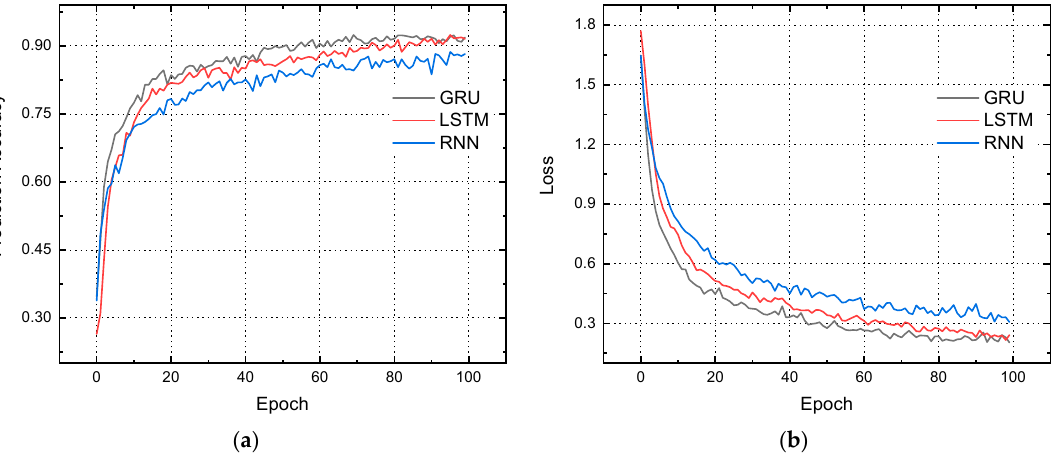
Figure 13. ( a ) Prediction accuracy of the models GRU, LSTM and RNN after testing 50% data; ( b ) Prediction loss of the models GRU, LSTM and RNN after testing 50% data.